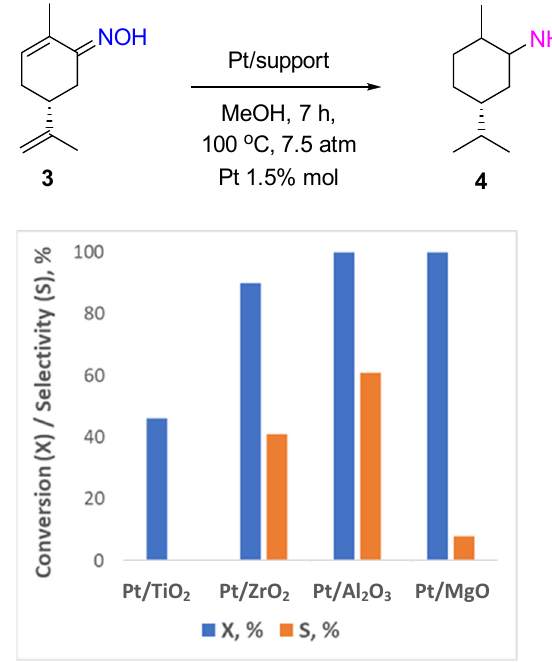
Figure 2. Hydrogenation of carvone oxime over Pt ‐ supported catalysts.